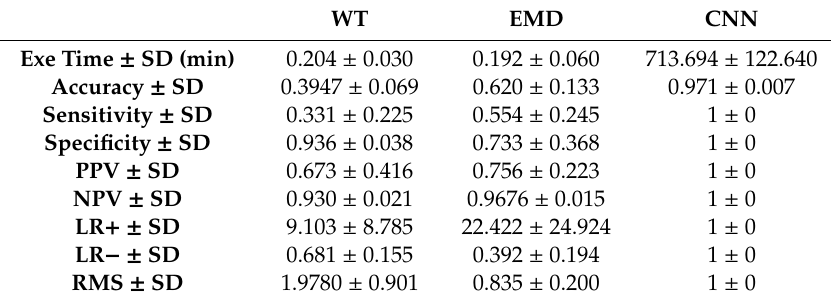
Table 2. Comparison between WT, EMD and CNN for Testing